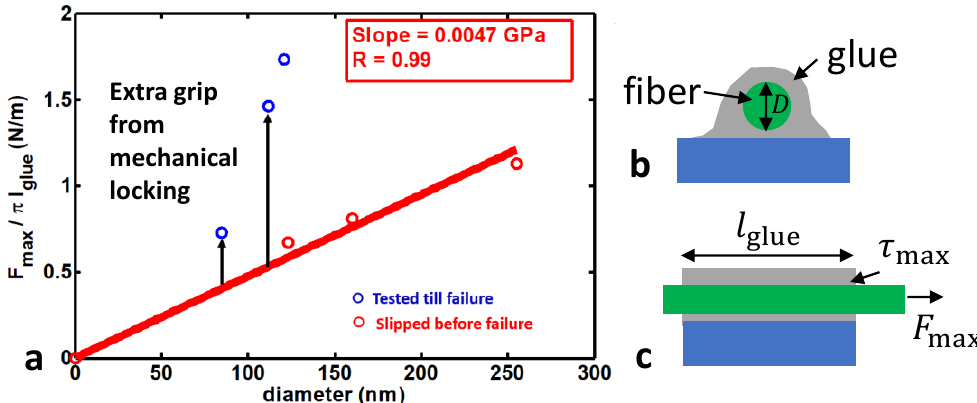
Figure 12. Estimate of glue shear strength. ( a ) Shear force per unit length versus fiber diameter for Loctite ® AA 3032/Henkel glue/fiber interface. The slope gives the shear strength of the glue/nanofiber interface. ( b , c ) are schematic cross-section and longitudinal views of the fiber in the glue. Adapted from reference [3] supplementary information.